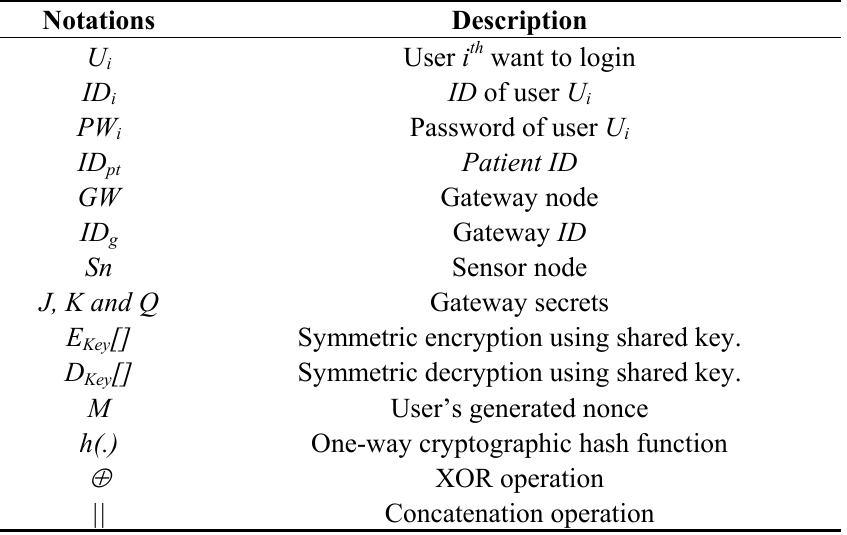
Table 1. Notation and